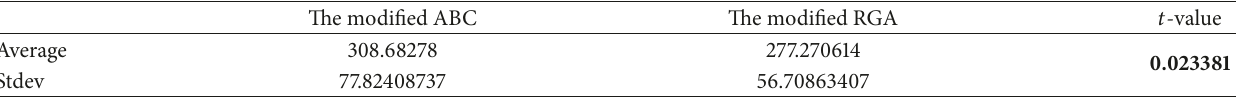
Table 3: The 𝑡 -value for MABC and MRGA in 49 degrees of freedom is significant at a QoS level of significance by two-tailed 𝑡 -test. The modified ABC The modified RGA 𝑡 -value Average